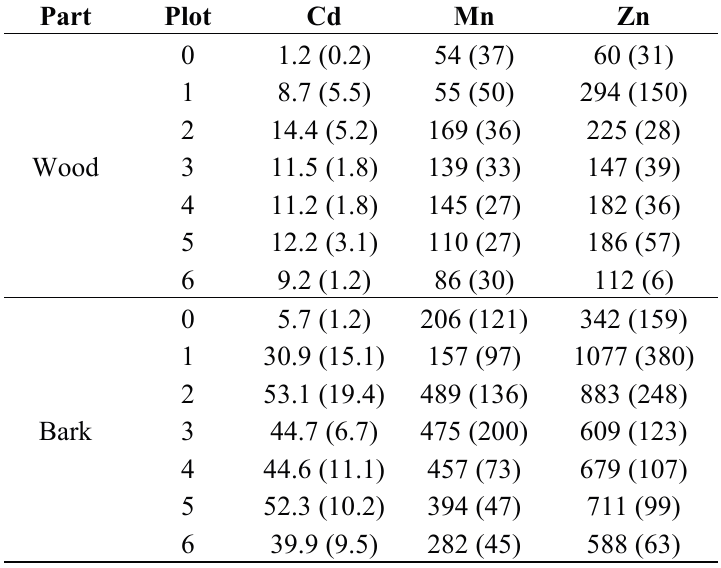
Table 3. Concentrations for Cd, Zn and Mn (mg/kg dry weight) in the bark and wood of cuttings for the reference plot (Plot 0), the plots emerged in 2003 (Plots 1 + 2 + 3) and the plots still submerged in 2003 (Plots 4 + 5 + 6) at the end of the growing season 2006. Values are the averages of 4 replicates per plot, with the standard deviations in